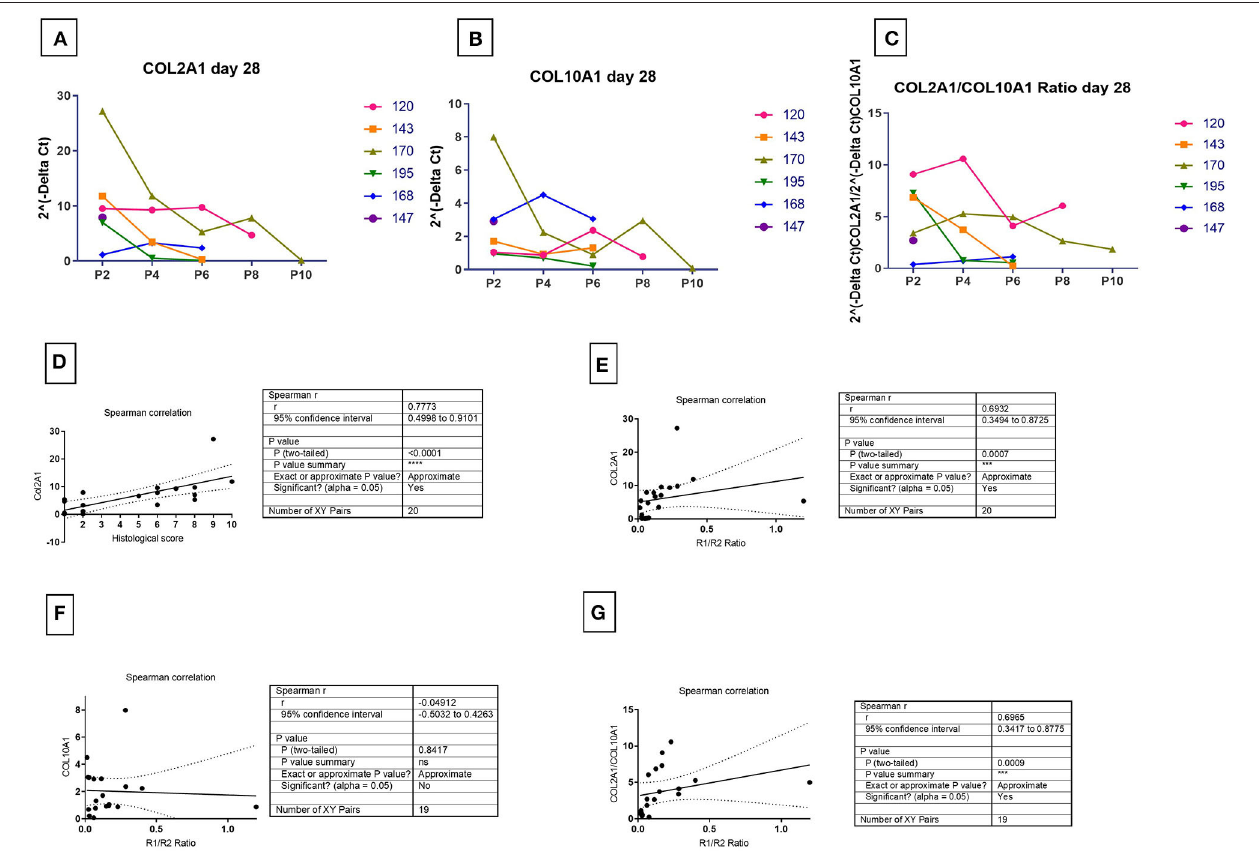
FIGURE 6 | Correlation of marker receptors ratio and chondrogenic outcome markers. The COL2A1 (A) , COL10A1 (B) , COL2A1/COL10A1 ratio (C) for mRNA at 28 days in chondrogenic medium was normalized to ribosomal protein large, P0 (RPLP0). The mRNA expression of receptors over time were plotted as 2 ( − 1 Ct ) . Spearman correlation for the detection of significance of hypothesis between R1/R2 and chondrogenic marker expression was done between the amount of COL2A1 and histological score (D) , the amount of COL2A1 and R1/R2 ratio (E) , the amount COL10A1 and R1/R2 ratio (F) , and COL2A1/COL10A1 ratio and R1/R2 ratio (G) . One sample had non-detectable levels of COL10A resulting in an n = 19 [Donor 195 P6- non-chondrogenic (see Supplementary Table 3